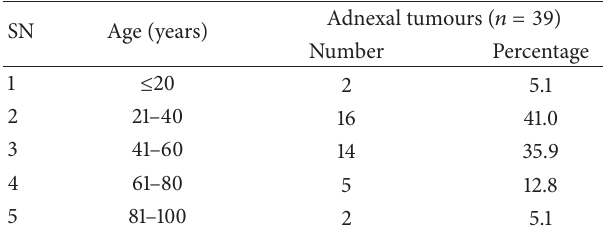
Table 1: Age-wise distribution of adnexal tumours.